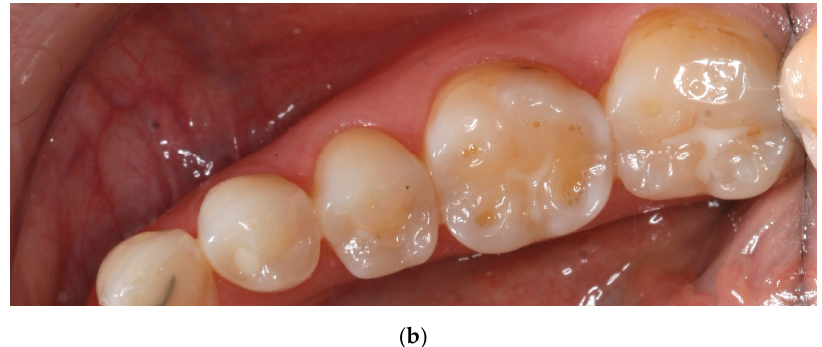
Figure 8. Similar appearance between the wear of medieval teeth ( a ) and the erosion with occlusal cupping in young people today ( b ).